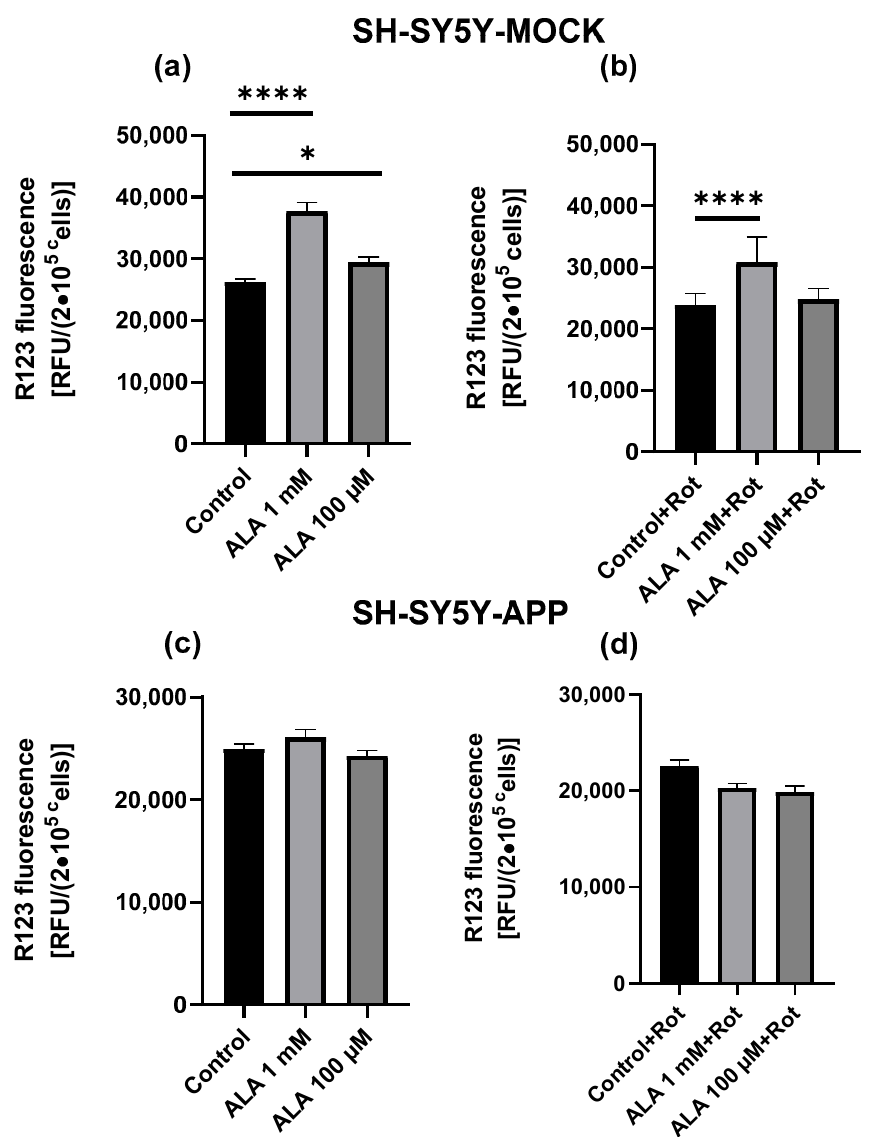
Figure 2. Effects of alpha lipoic acid (ALA) on mitochondrial membrane potential (MMP) in SH- SY5Y-MOCK. ( a ) Cells were incubated with ALA at different concentrations for 24 h and measured against cells treated with ethanol the solvent of ALA. ( b ) MMP in rotenone (R) [25 µ M] treated SH-SY5Y-MOCK cells. Before rotenone impairment, SH-SY5Y-MOCK cells were incubated with either ALA 100 µ M, 1 mM, or ethanol for 1 h before exposure to 25 µ M rotenone for another 24 h. SH-SY5Y-APP 695 cells were treated in the same way. ( c ) Treatment with ALA and ethanol. ( d ) Additional damage with rotenone. Data are displayed as the means ± SEM. N = 12–23. Statistical significance was tested via one-way ANOVA and Tukey’s post-hoc test (**** p < 0.0001, * p < 0.05).